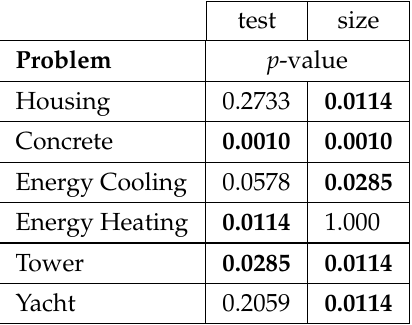
Table 3. Friedman test p -values, comparing the sequential neat-GP-LS and the EvoSpace implementation based on test RMSE and average size of the final population. Bold indicates that the null-hypothesis was rejected at the α = 0.05 significance level.